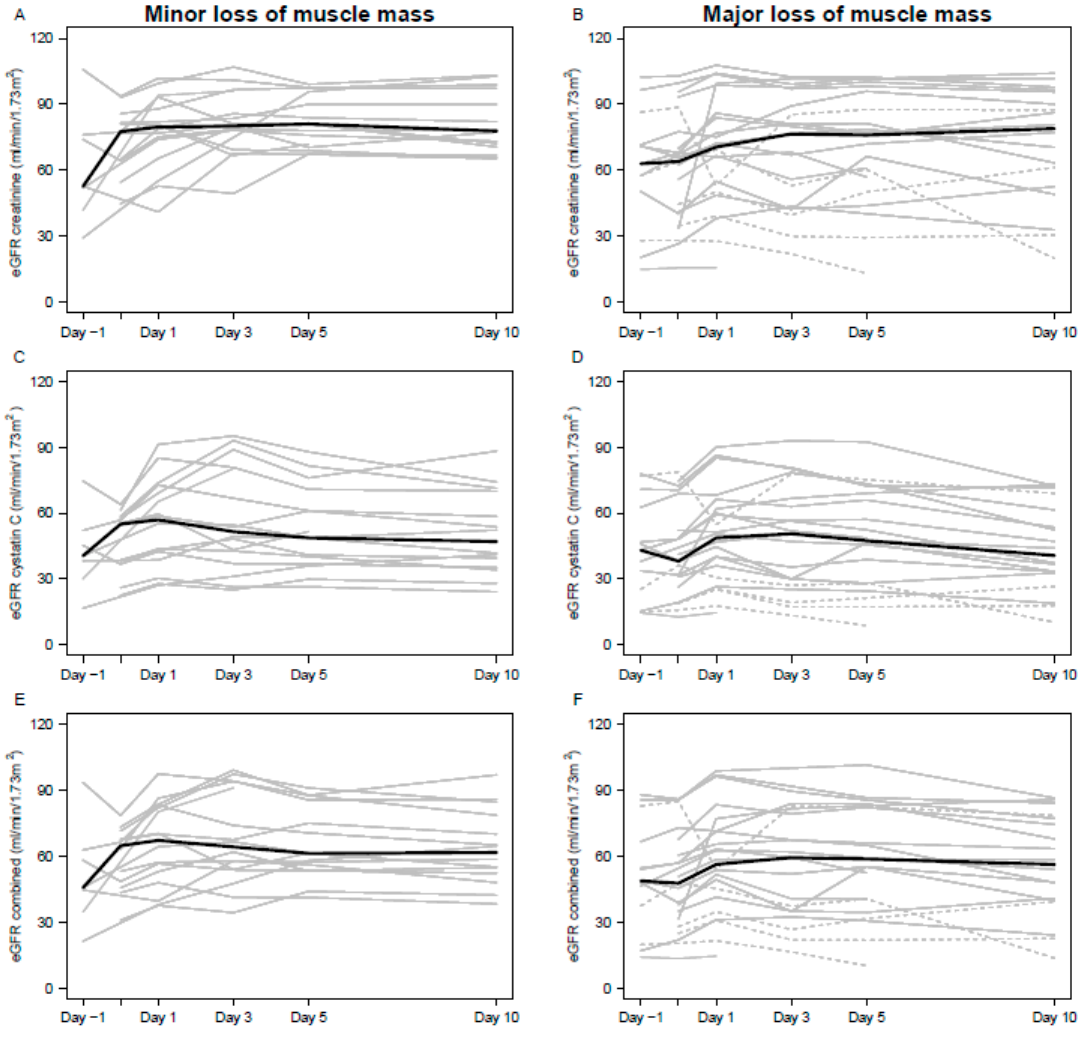
Figure 1. The level of eGFR during lower extremity amputation ( n = 38). Light grey lines represent each patient of which dashed lines are patients with potential acute kidney injury. Solid, black lines are the